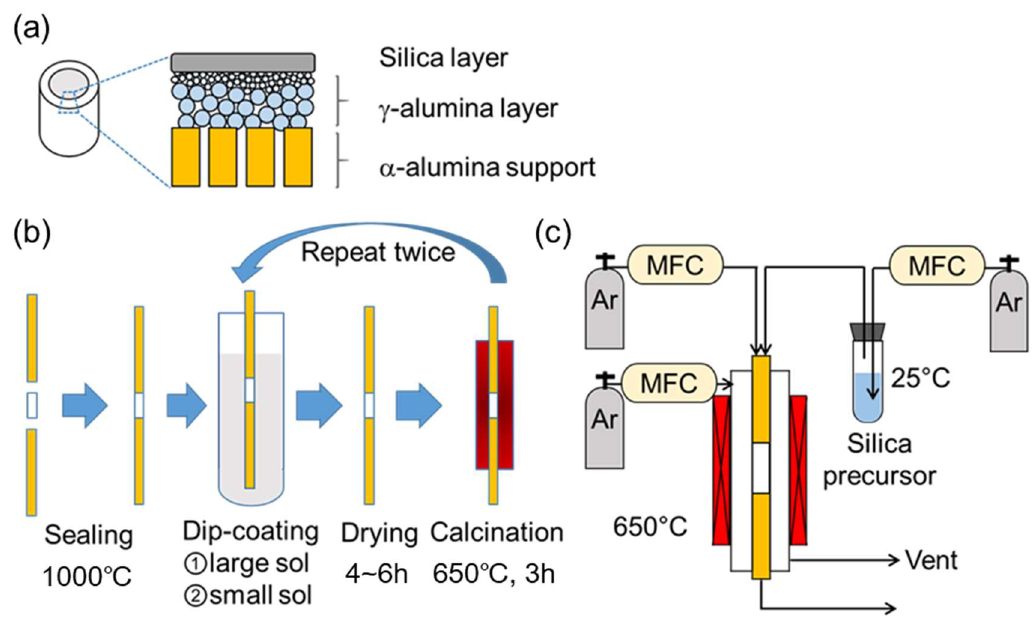
Figure 1. ( a ) Structure of the prepared silica membrane, ( b ) scheme of the dip-coating cycle, and ( c ) the chemical vapor deposition (CVD) apparatus.